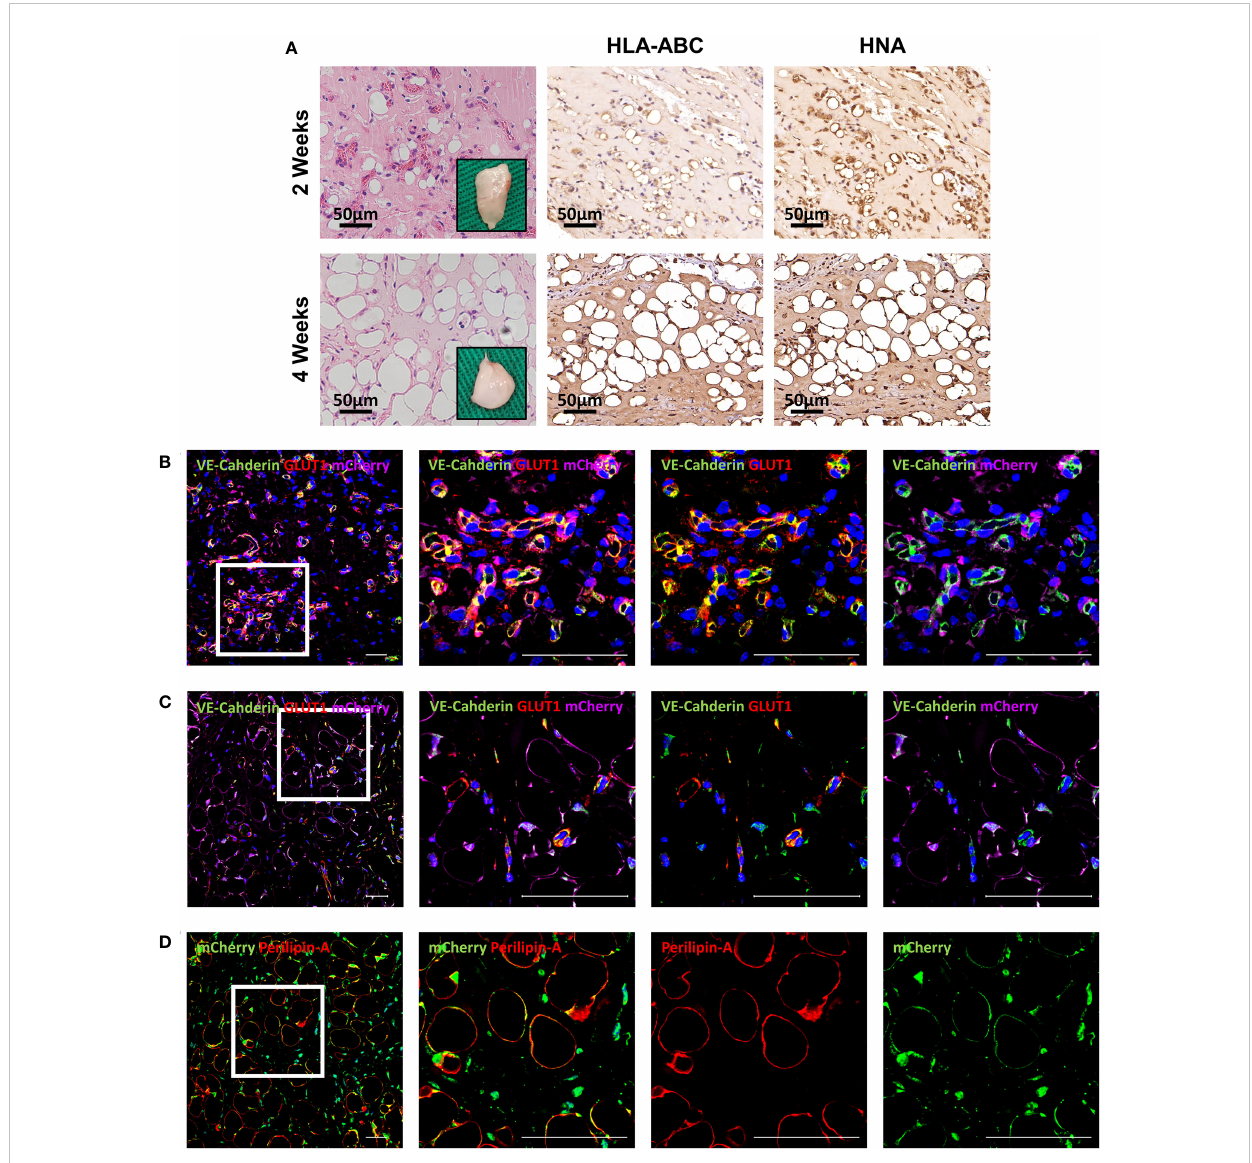
FIGURE 6 Combined injection of HemMCs and HUVECs leads to the formation of GLUT1 + vessels in vivo . (A) A mixture of HUVECs and HemMCs in Matrigel was injected into nude mice. Explants were harvested at 2 and 4 weeks and then subjected to H&E staining and IHC staining of HLA-ABC and HNA. Scale bars=50 m m. (B-D) A mixture of HUVECs and mCherry-labeled HemMCs in Matrigel was injected into nude mice. Short scale bars=50 m m; long scale bars=100 m m. (B) Explants were harvested at 2 weeks and then subjected to immunostaining for VE-cadherin (green), GLUT1 (red) and mCherry (magenta). (C) Explants were harvested at 4 weeks and then subjected to immunostaining for VE-cadherin (green), GLUT1 (red) and mCherry (magenta). (D) Explants were harvested at 4 weeks and then subjected to immunostaining for Perilipin-A (red) and mCherry (green). HemMCs, infantile hemangioma mural cells; HUVECs, human umbilical vein endothelial cells; GLUT1, glucose transporter 1; H&E, hematoxylin and eosin; IHC, immunohistochemistry; HLA-ABC, human leukocyte antigen-ABC. HNA, human nuclei antigen; VE-cadherin, vascular endothelial